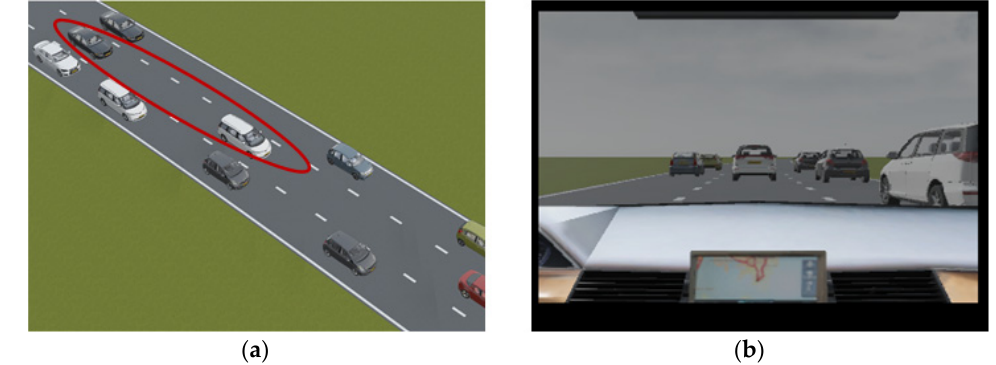
Figure 17. Safe Traffic Dynamic Scenario in the simulation environment from ( a ) top-view and from ( b ) driver’s view.